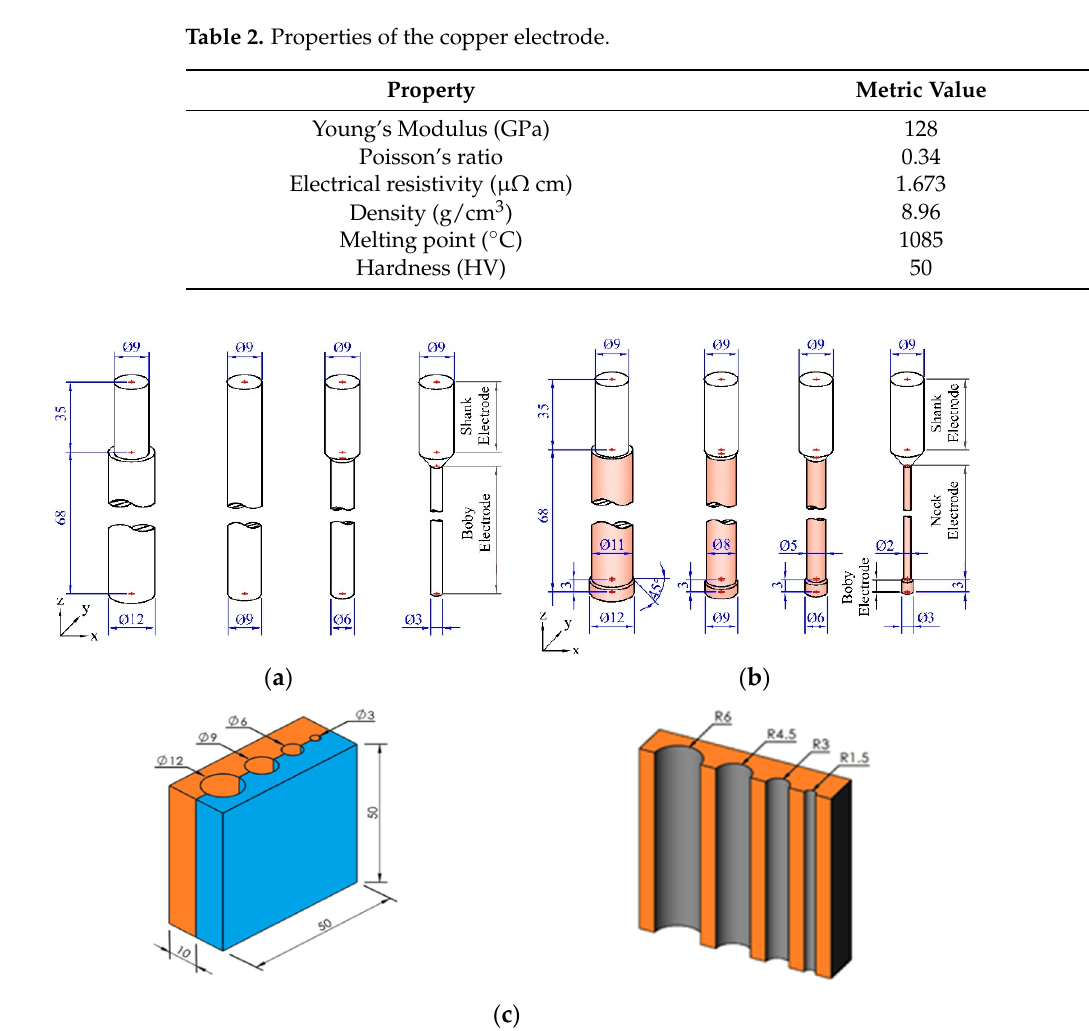
Figure 2. Schematic of copper electrode and AISI P20 workpiece. ( a ) Conventional electrode (CE); ( b ) step cylindrical electrode, SCE; ( c ) feature of the workpiece by section view.